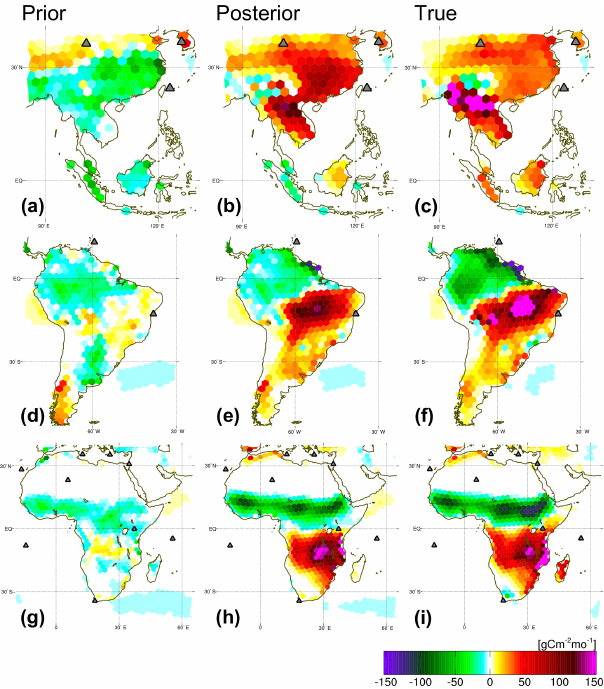
Figure 8. The same as Fig. 7 but focused on regional flux anomalies due to biomass burnings for southeast Asia in March (a–c) , South America in September (d–f) , and Africa in September (g–i) . Gray triangles denote locations of the observational sites.